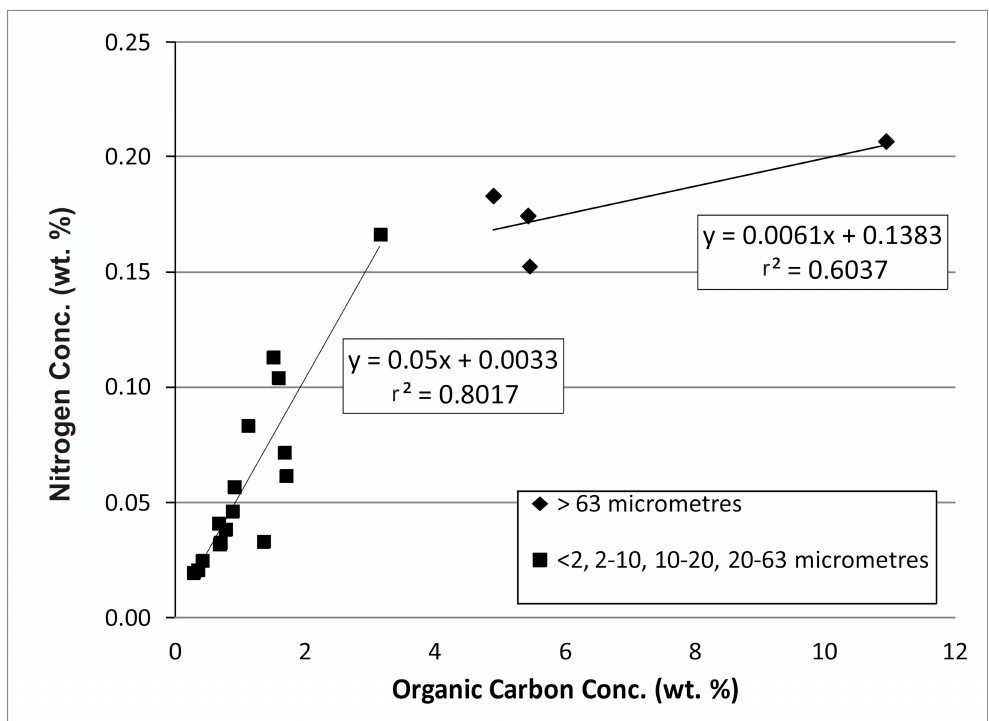
Figure 11. Plot of Organic Carbon (C org ) versus Total Nitrogen (TN) for size fractionated samples. Note, the 63 µm fraction falls on a separate regression ( r 2 = 0.6) than the other four fractions ( r 2 = 0.8).